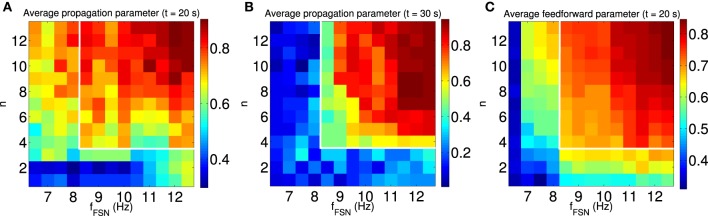
Synchronous activity propagation is sustained only if the network is feedforward. We systematically characterized the propagation of synchronous activity in the network as a function of two properties of the local excitation: the extend and the intensity of local excitation. (A,B) The average propagation parameter in the steady state [t = 20 s, (A)] and after removing the local excitation [t = 30 s, (B)] indicated by the color scale. The white outline indicates the region with sustained propagation of synchronous activity in the absence of local excitation. Note that for some parameters synchronous activity propagates through the network only when the local excitation is present. (C) The average feedforward parameter in the steady state (t = 20 s) is indicated by color scale. Only when the structure of the network is mostly feedforward (average feedforward parameter approximately ≥ 0.7), is the synchronous activity propagation sustained after removing the local excitation (see white outlines). All data points are averaged across 100 simulations with different random input currents.